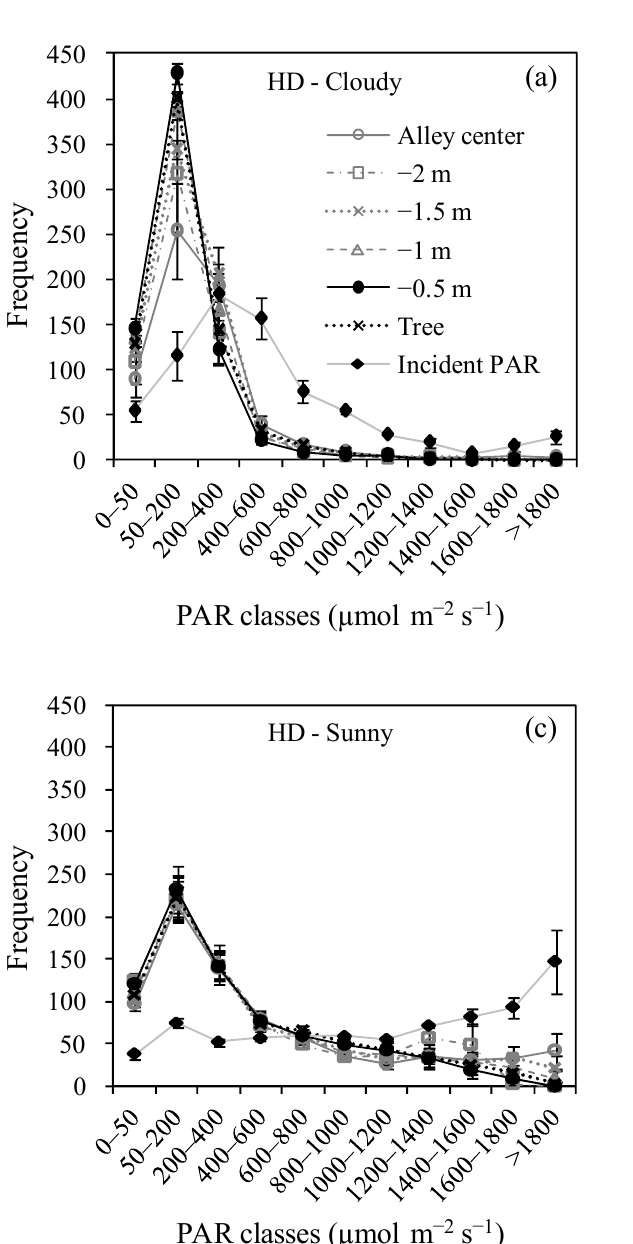
positions: the most shaded positions (e.g., below the tree and at − 0.5 m: black lines) were much more skewed towards lower classes, compared to the most illuminated positions